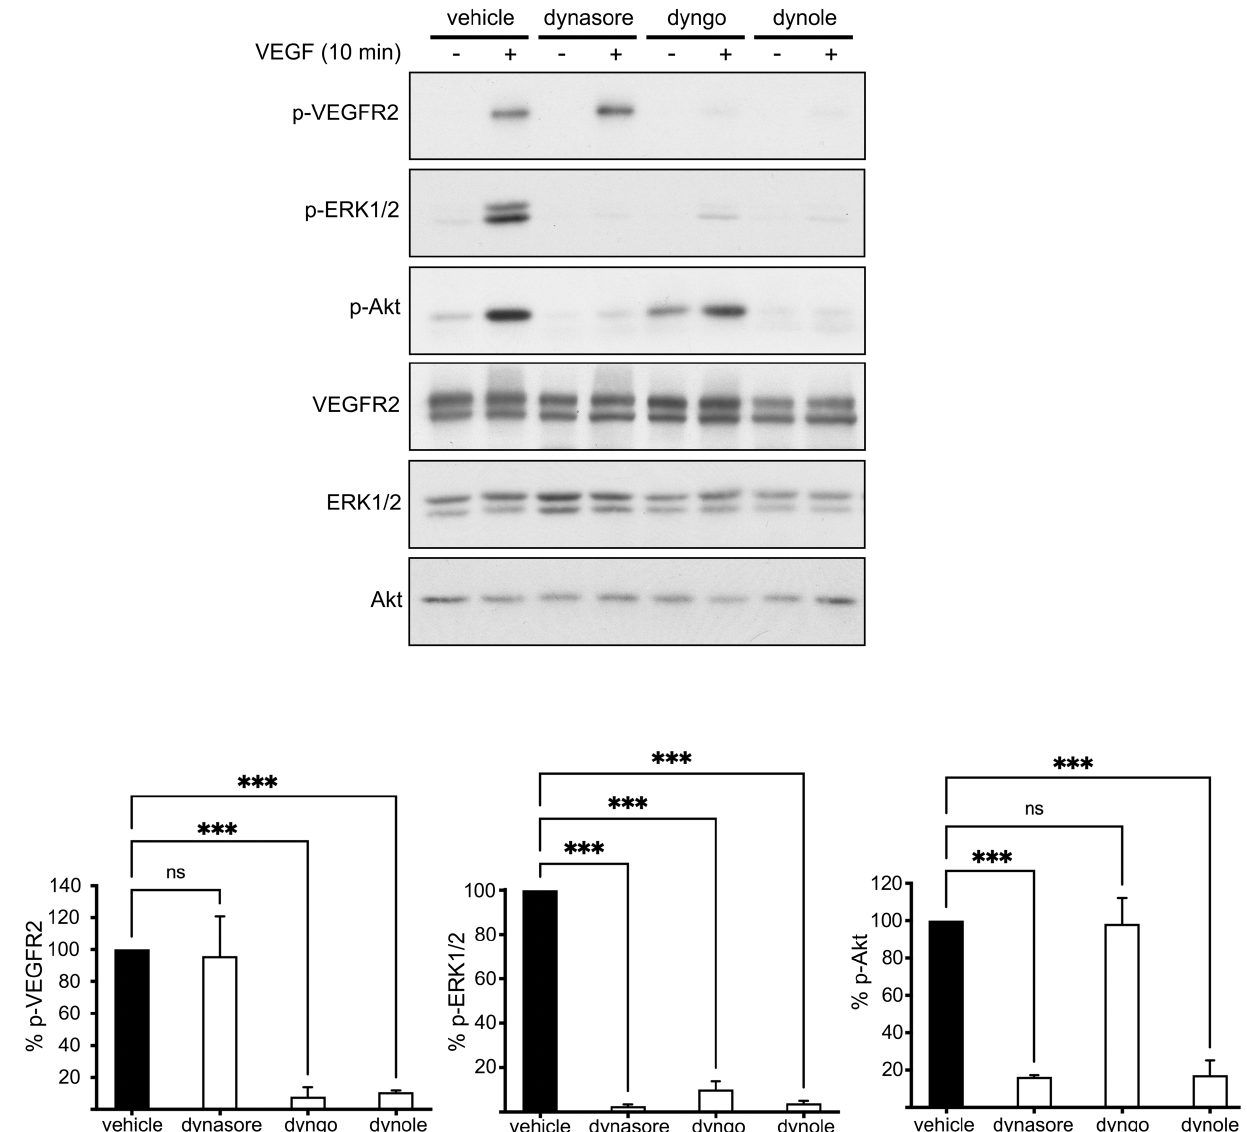
Figure 4. Chemical inhibitors of dynamin exert differential effects in VEGF signaling. Serum-starved HUVECs were subjected to 30 min treatment with vehicle or inhibitors of dynamin, followed by stimulation with VEGF (50 ng/mL) for 10 min. Subsequently, cells were lysed and were subjected to immunoblotting analysis using antibodies against the total or the phosphorylated protein forms of VEGFR2, ERK1/2 and Akt. Quantification of the effect of inhibitors on the VEGF-induced phosphorylation of VEGFR2 or ERK1/2 or Akt is shown on the right of the immunoblots (n = 3 independent experiments, mean ± S.E.M., *** p < 0.001, ANOVA). The Western blots corresponding to pERK1/2 and total ERK1/2 of vehicle- and dyngo-treated samples are reproduced from Figure S5a of our previous report [18], which falls under Creative Commons Attribution